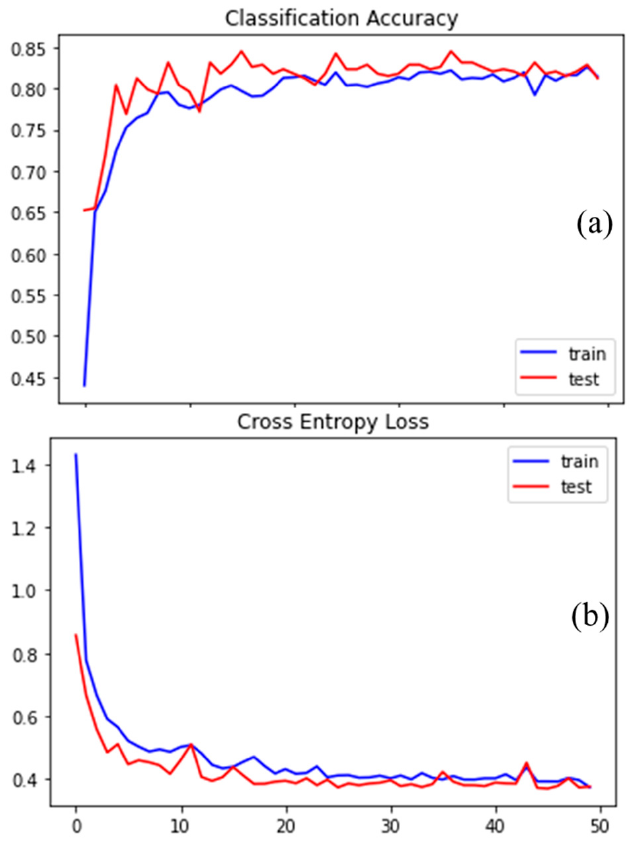
Figure 14. Convergence of the training and validation process of VGG19: ( a ) accuracy and ( b ) cross-entropy loss.